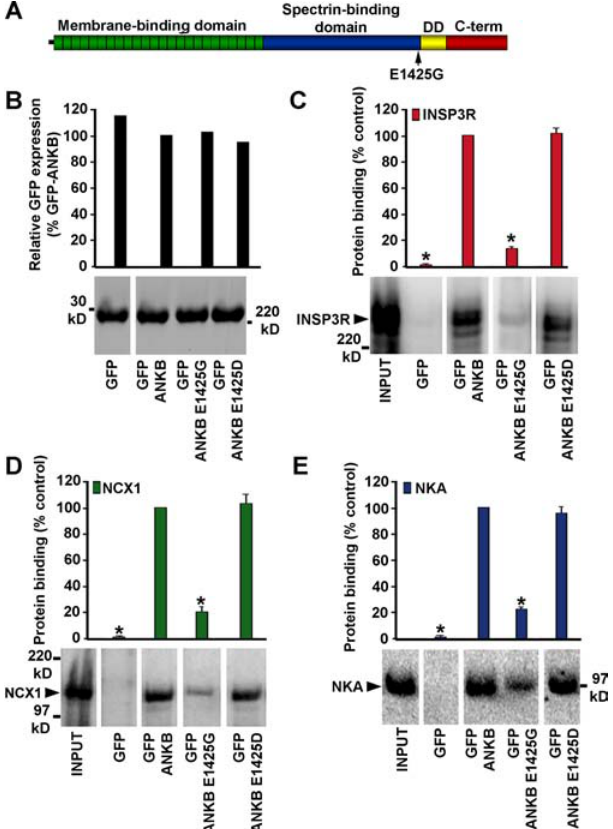
Figure 7. Human Ankyrin-B E1425G Mutation Abolishes Binding to NKA, NCX1, and InsP 3 R (A) 220-kDa ankyrin-B domain organization. The human LQT4 E1425G mutation is marked. (B) Immunoblot of expressed wild-type and mutant GFP-ankyrin-B proteins. (C–E) Relative binding of rat heart lysate (C) InsP 3 R, (D) NCX1, and (E) NKA to wild-type and mutant GFP-ankyrin-B proteins. Bound NCX1, NKA, and InsP 3 R were evaluated following quantitative immunoblot (pan-InsP 3 R, pan-NKA, and NCX1 Ig) and phosphorimaging ( n ¼ 3, p , 0.05). DOI: